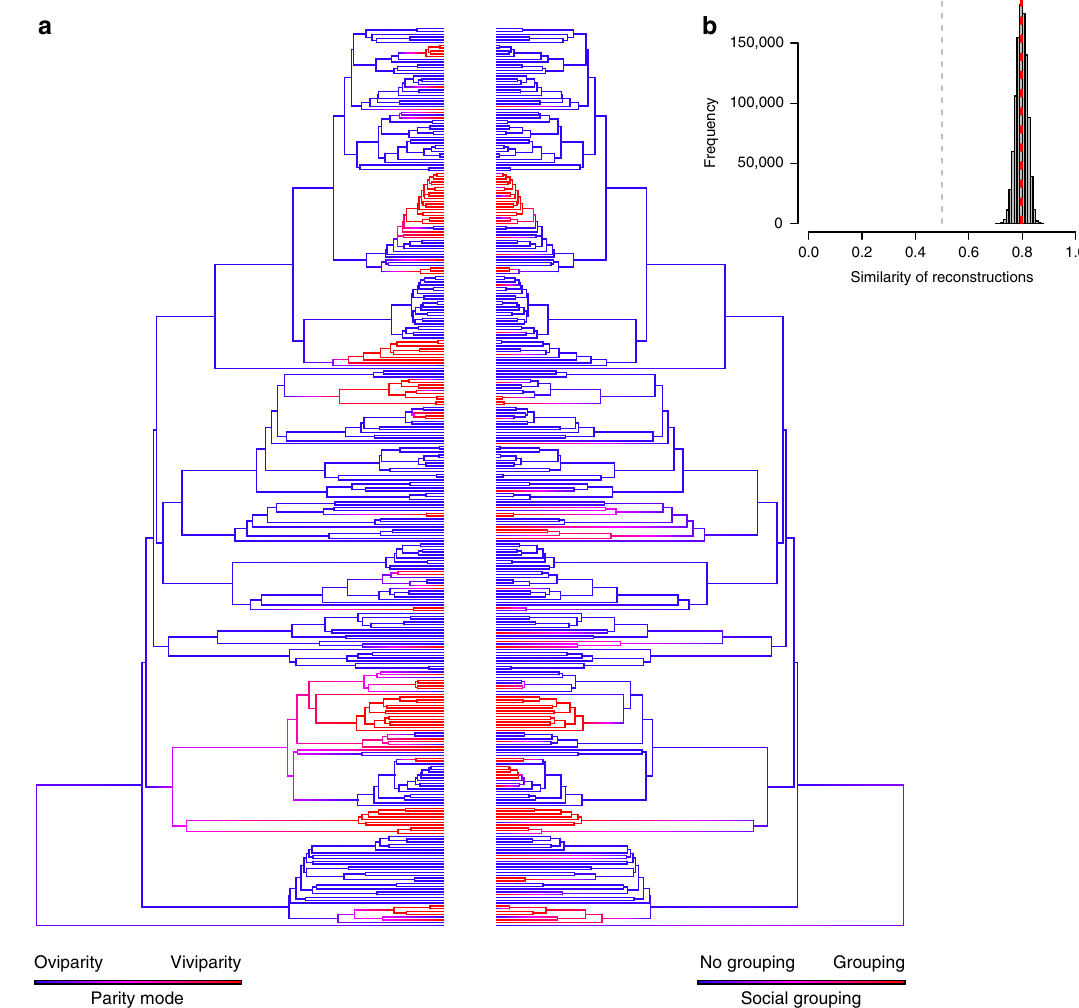
Fig. 3 Correlated evolution of viviparity and social grouping among squamate reptiles. a Ancestral state reconstructions of parity mode and social grouping by stochastic character mapping. Phylogeny restricted to species in the ‘ conservative ’ data set ( n = 324, see Methods for details). Branch colours represent posterior probability densities of edge states based on 1000 stochastic character maps of each reconstruction. b Distribution of similarity scores between stochastic character map sets based on separate ancestral character state reconstructions of parity mode and social grouping. The grey line represents the null expectation of similarity between map sets assuming parity mode, and social grouping shows no evolutionarily correlation during reconstruction 65 . The red line represents the mean similarity between map sets based on our